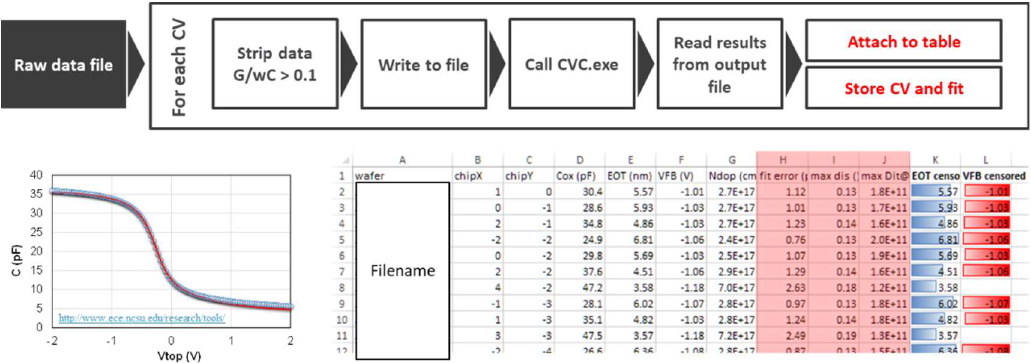
Figure A2. Example procedure of data extraction from measurement.